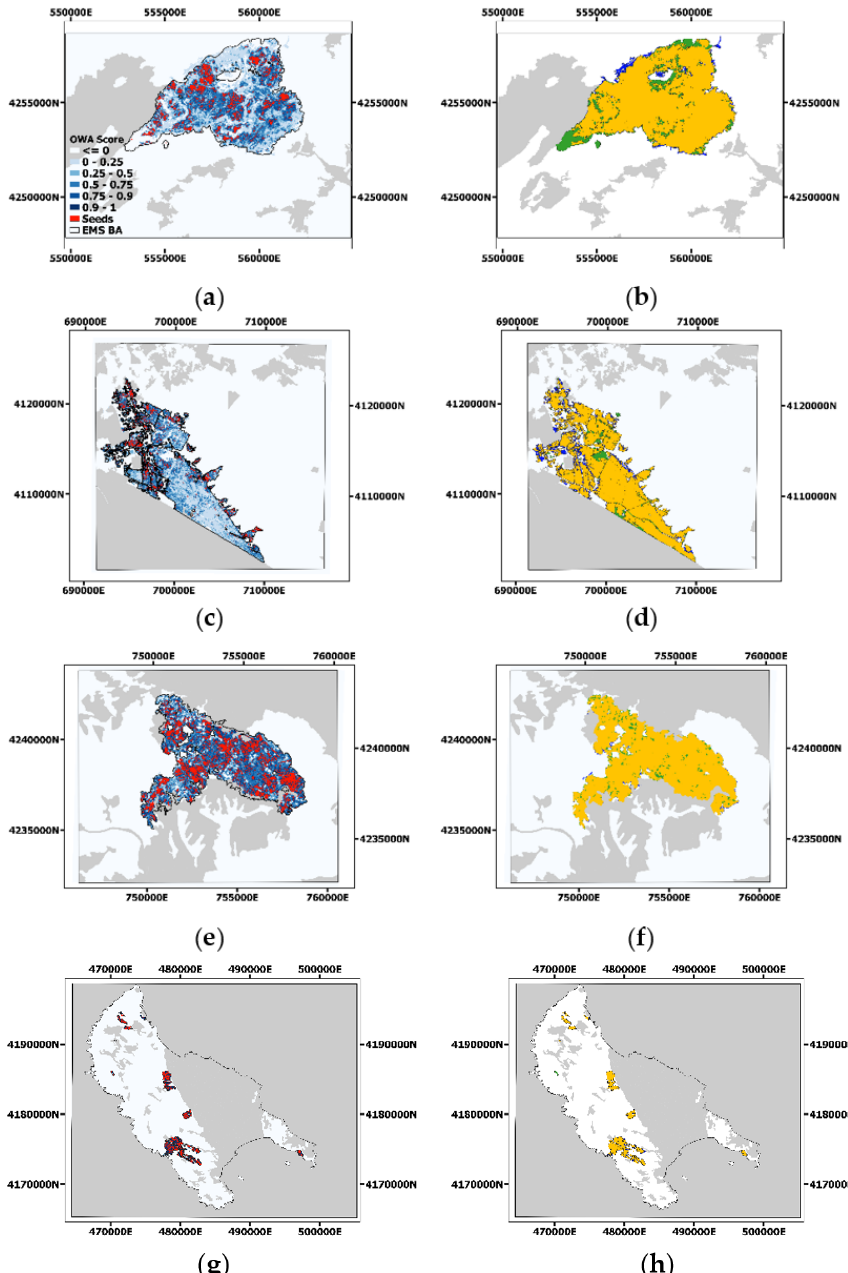
Figure 6. Left: The RG score maps (shades of blue) output from the algorithm (left column) with high- lighted seed points (red pixels) and EMS reference perimeters (black line). Right: the accuracy maps (correct burned TP = orange, correct unburned TN = white, omission FN = green and commission FP = blue) for the four study sites: Calar, SP ( a , b ), Huelva, SP ( c , d ), Kalamos, GR ( e , f ) and Zakynthos, GR ( g , h ). Unburnable masked regions are